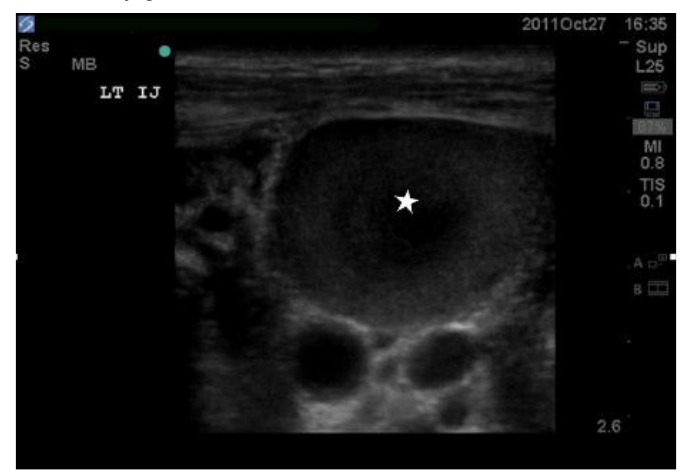
Figure 3. Ultrasound image demonstrating clot in left IJ (star). IJ , internal